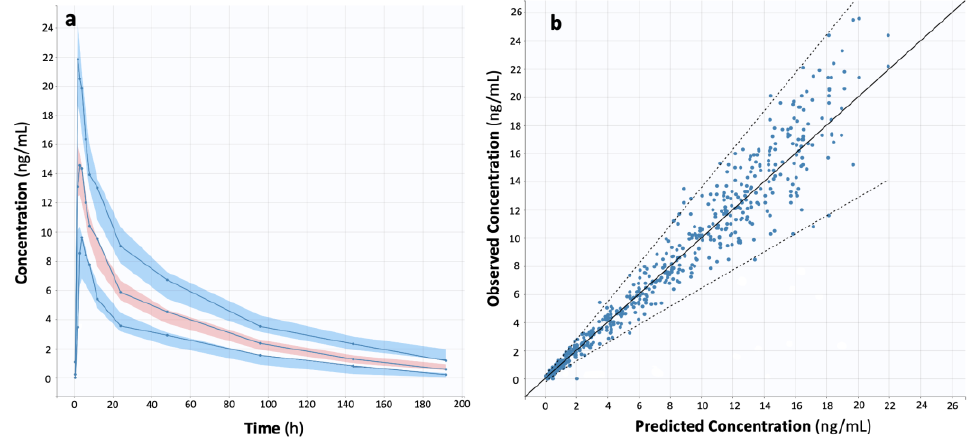
Figure 4. Goodness of fit plots for the finally selected population pharmacokinetic model for donepezil. ( a ) Visual predictive check plot where the blue lines show the 10th, 50th, and 90th percentiles of the empirical data, while the shaded areas represent the anticipated 90% confidence intervals. A number of 1000 Monte Carlo simulations were utilized. ( b ) Individual observed vs. predicted individual concentrations of donepezil. Closed circles refer to (predicted, observed) pairs, solid lines denote the ideal condition of unity (i.e., y = x), and dotted lines represent the 90% prediction interval.